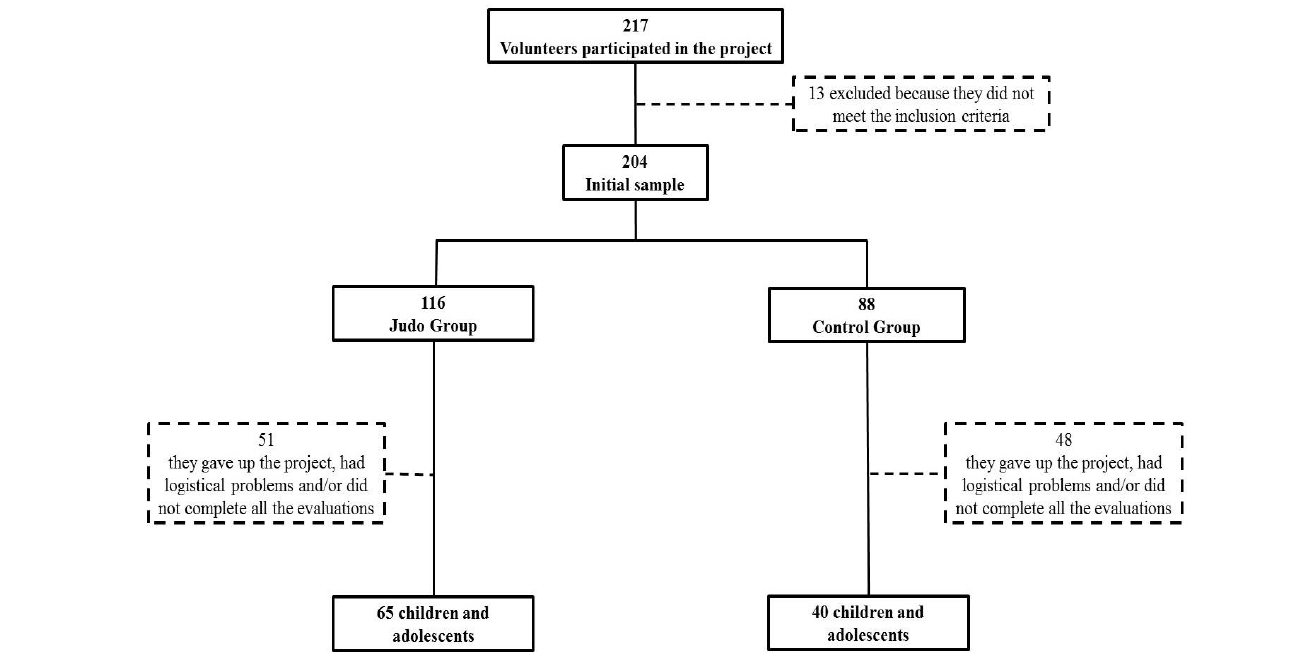
Figure 1. Flow chart of the